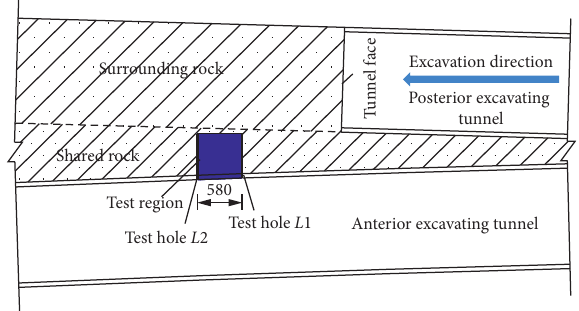
Figure 12: Layout of test region (unit: cm).